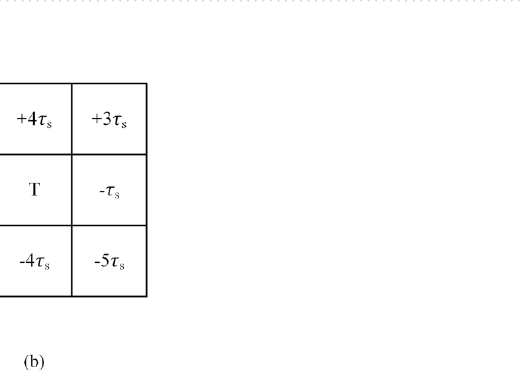
Figure 1. Processing flowchart of the Riemannian geometry-based transfer learning in c-VEP BCIs. The meanings of the acronyms in the figure are as follows. LOO: leave-one subject-out; SSs: source subjects; TS: target subject; LE(DA): log-Euclidean (data alignment); SCMs: sample covariance matrices; TSS: training accuracy-based subject selection; MDM: minimum distance to mean.